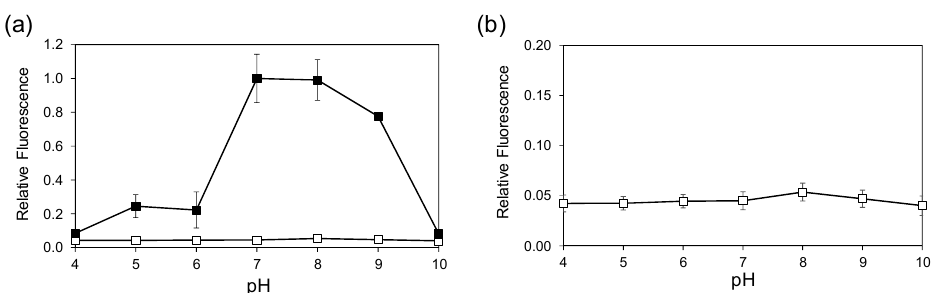
Figure 5. ( a ) E ff ect of pH on the fluorescence properties of 5b in the absence ( (cid:3) ) and presence ( (cid:4) ) of Figure 5. ( a ) Effect of pH on the fluorescence properties of 5b in the absence ( □ ) and presence ( ■ ) of Zn 2 + . ( b ) Enlarged figure of 5b in the absence ( (cid:3) ) of Zn 2 + . Zn 2+ . ( b ) Enlarged figure of 5b in the absence ( □ ) of Zn 2+ .